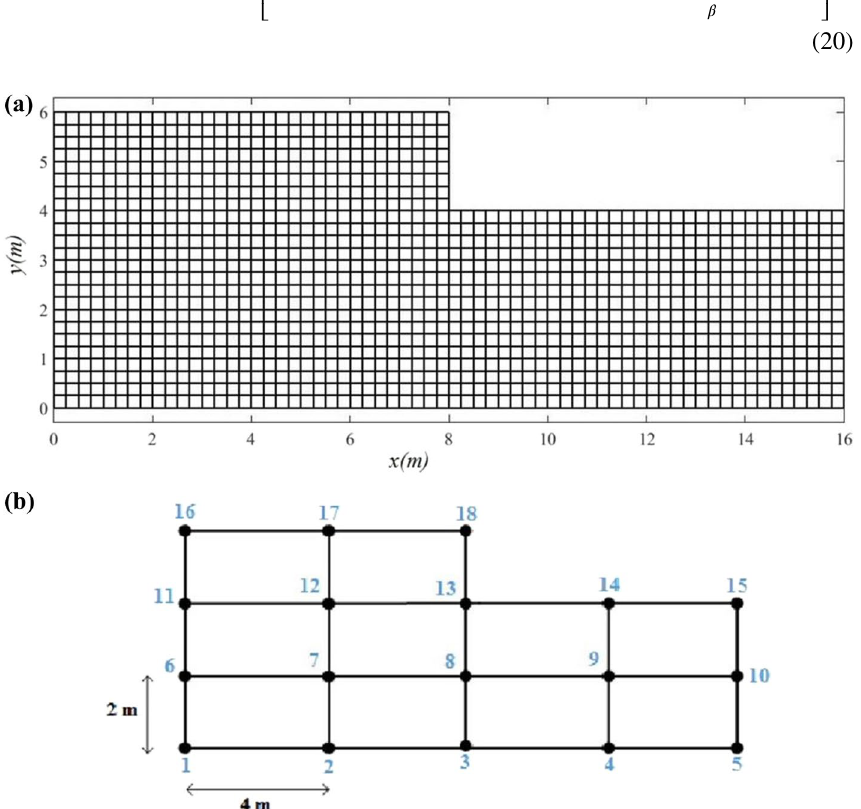
Fig. 4 Computational domain and boundary conditions for the first problem